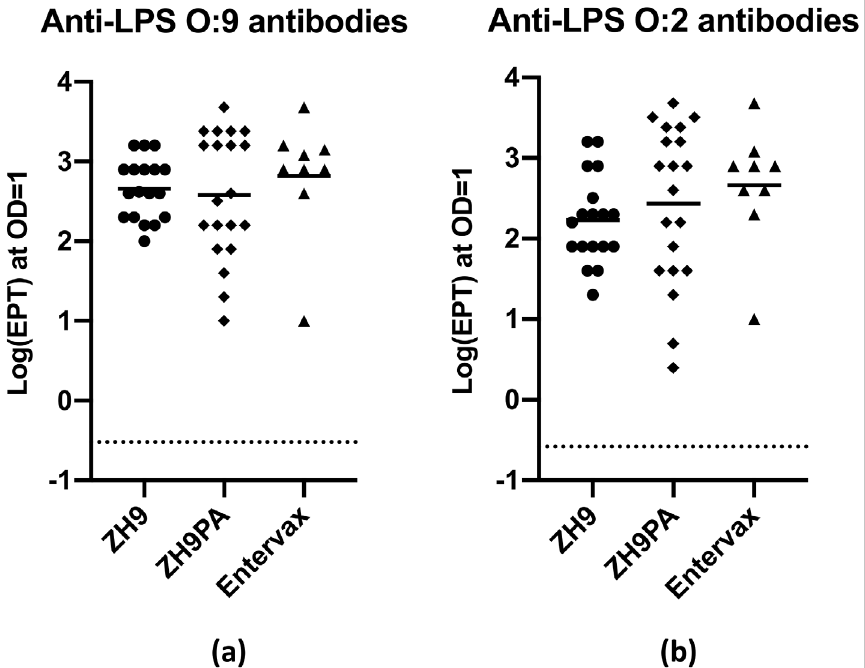
Figure 5. Anti-LPS IgG antibody responses following in vivo vaccination. ( a ) Specific IgG antibody responses against S. Typhi LPS (O:9). ( b ) Specific IgG antibody responses against S. Paratyphi A LPS (O:2). Antibody responses were evaluated by ELISA in Balb/c mouse serum at 35 or 42 days following subcutaneous vaccination with 10× 8 CFU ZH9 (•), 10× 8 CFU ZH9PA ( ♦ ) or a 1:1 mix of 0.5×10 8 CFU of ZH9 and 0.5×10 8 CFU of ZH9PA (Entervax™ basic formulation ( ▲ )). Pre-vaccination (d0) samples were pooled across individual mice to generate the negative assay control (dotted line). Each data point represents an individual mouse, and data were pooled across three independent experiments. Mean values are represented by the horizontal bar. Statistical comparisons were made using a one-way ANOVA. ELISA = enzyme-linked immunosorbent assay; EPT = end point titre; IgG = immunoglobulin G; LPS = lipopolysaccharide; OD = optical density.